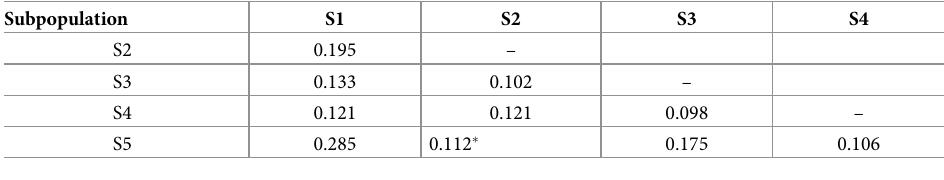
Table 1. Pair-wise genetic differentation coefficients ( F ST ) among five subpopulations of yellow-necked mice in NE Poland, defined by SAMOVA (see map in Fig 5). All values were statistically significant at p < 0.005 after Bonfer- roni correction ( k = 10) except that marked by asterisk ( � ).